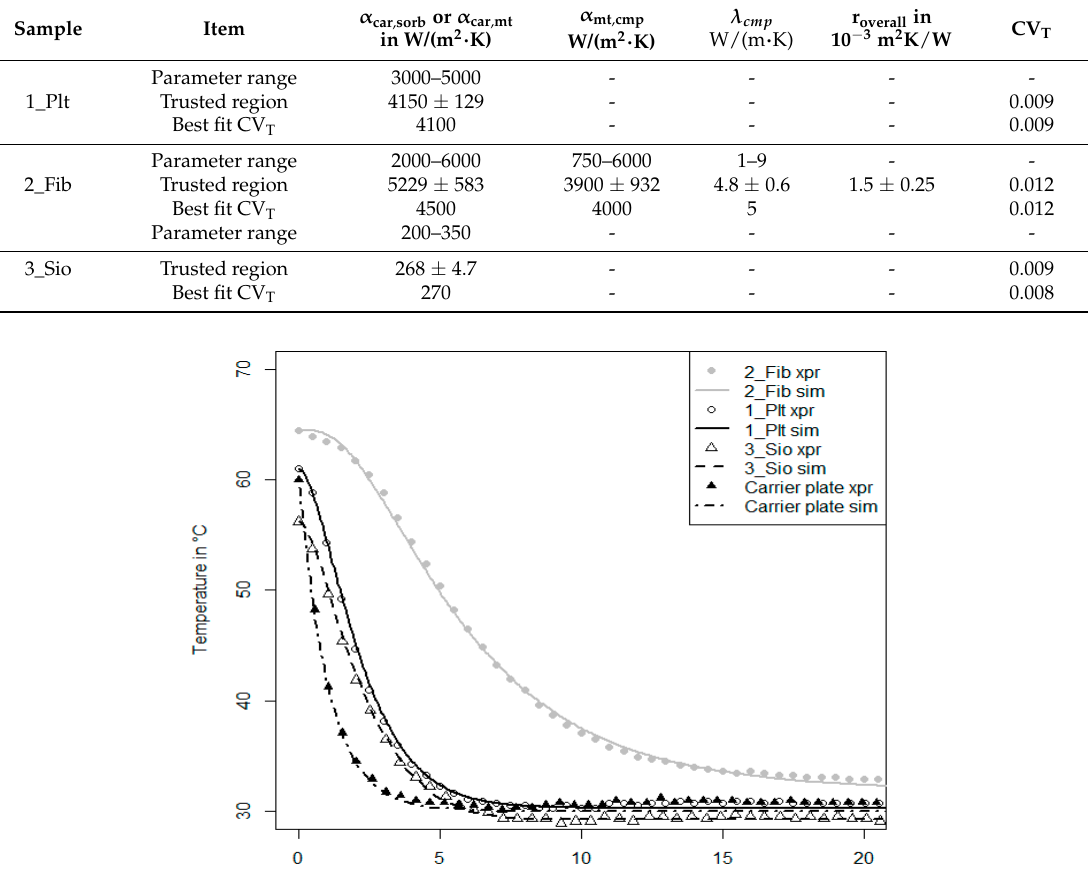
Table 7. Identified heat transfer parameters for the inert-LTJ measurements under adsorption conditions for three different samples.